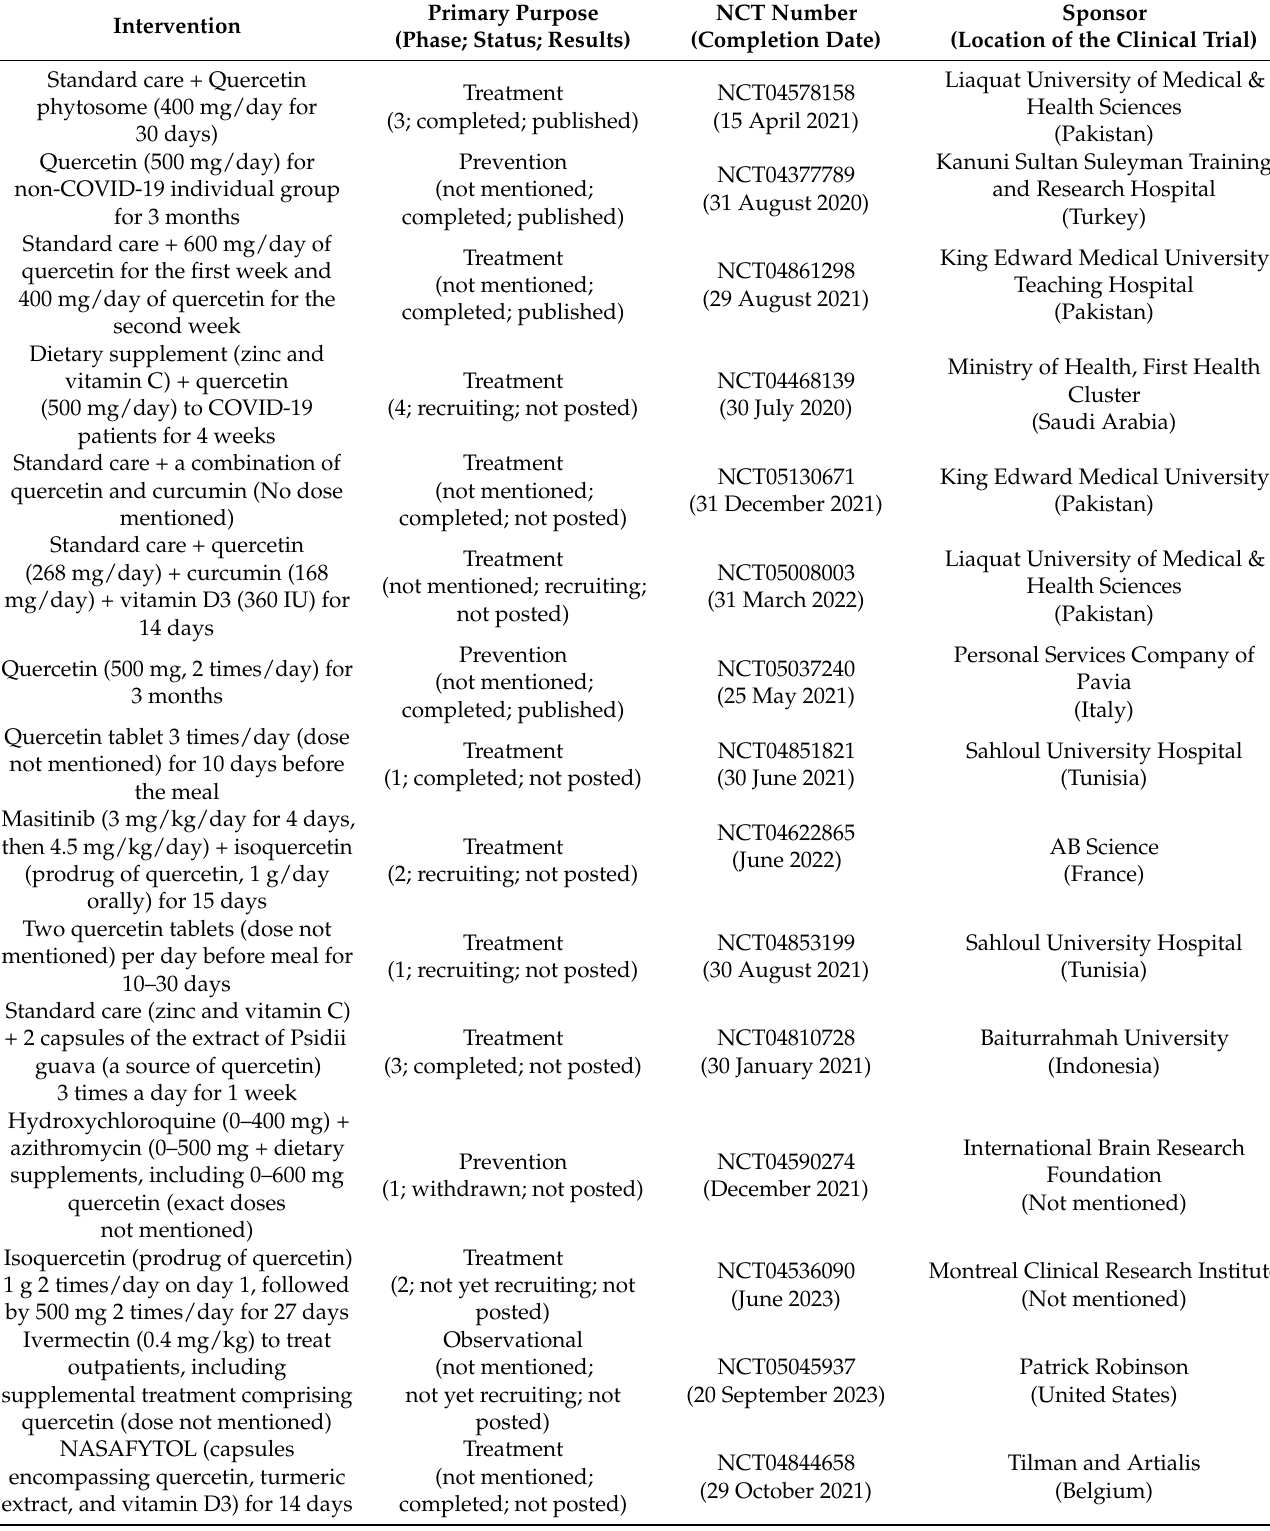
Table 1. Clinical studies on quercetin and its compositions against